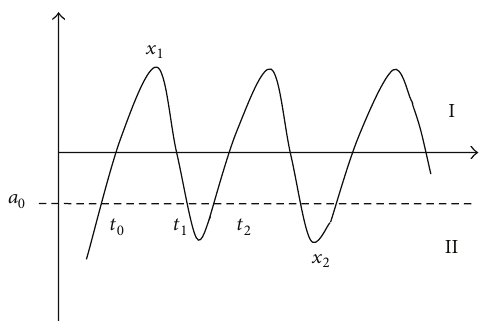
Figure 2: Periodic large amplitude response of the overall system.